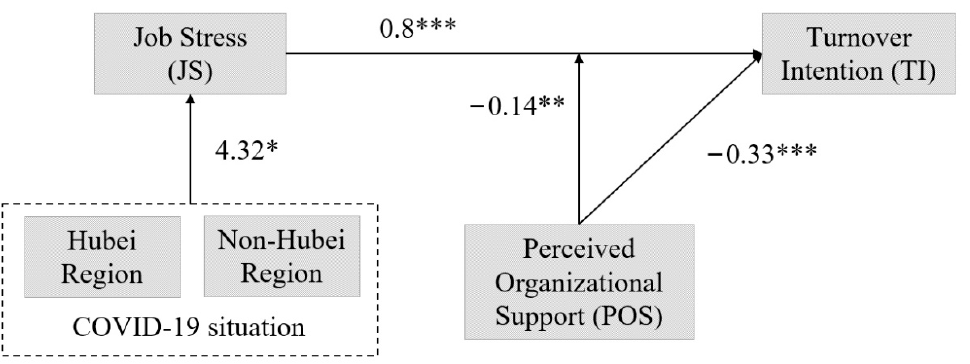
Figure 2. The theoretical framework with the hypotheses testing results. Source: authors’ own elaboration. Note: * p < 0.05; ** p < 0.01; *** p < 0.001.